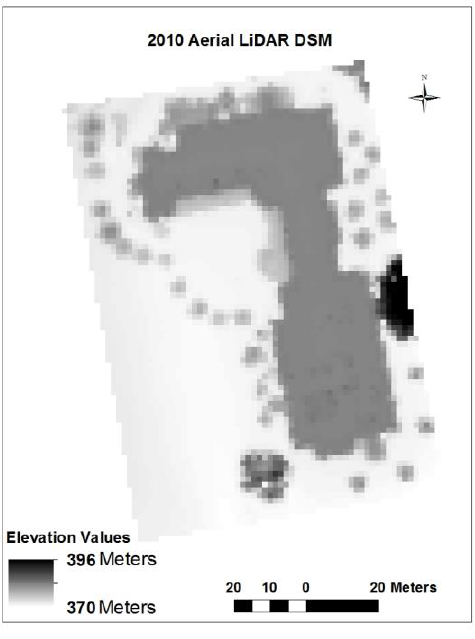
Figure 3. Aerial LiDAR 2010 based DSM